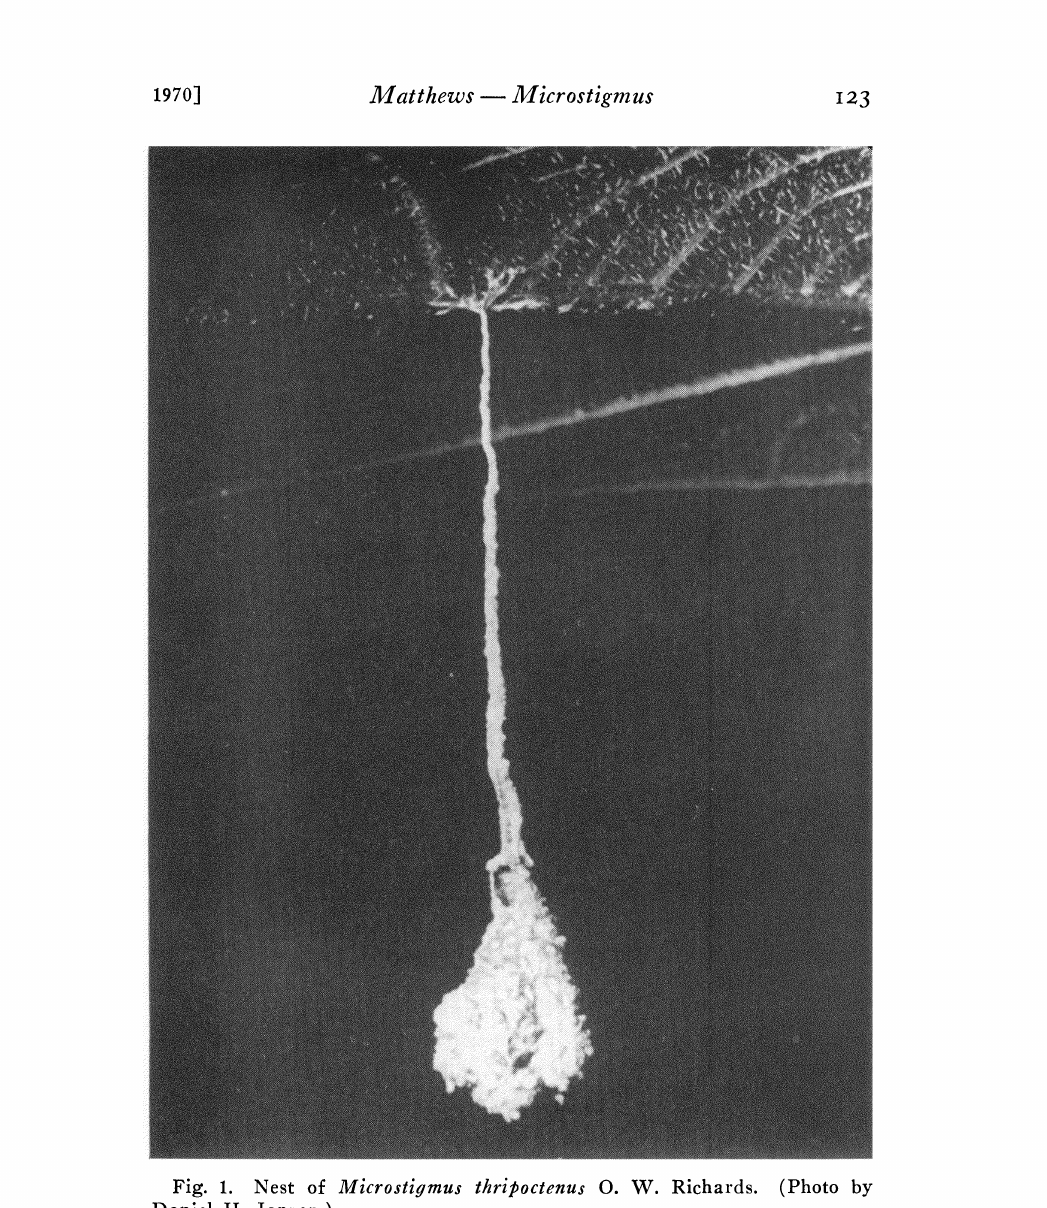
Fig. 1. Nest of Microstigmus thripoctenus O. W. Richards. (Photo by Daniel H.